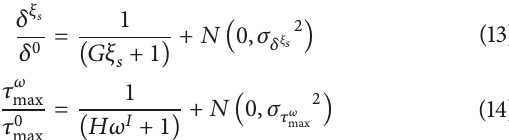
standard deviation ( 𝜎 ) of the residuals are 0.00304